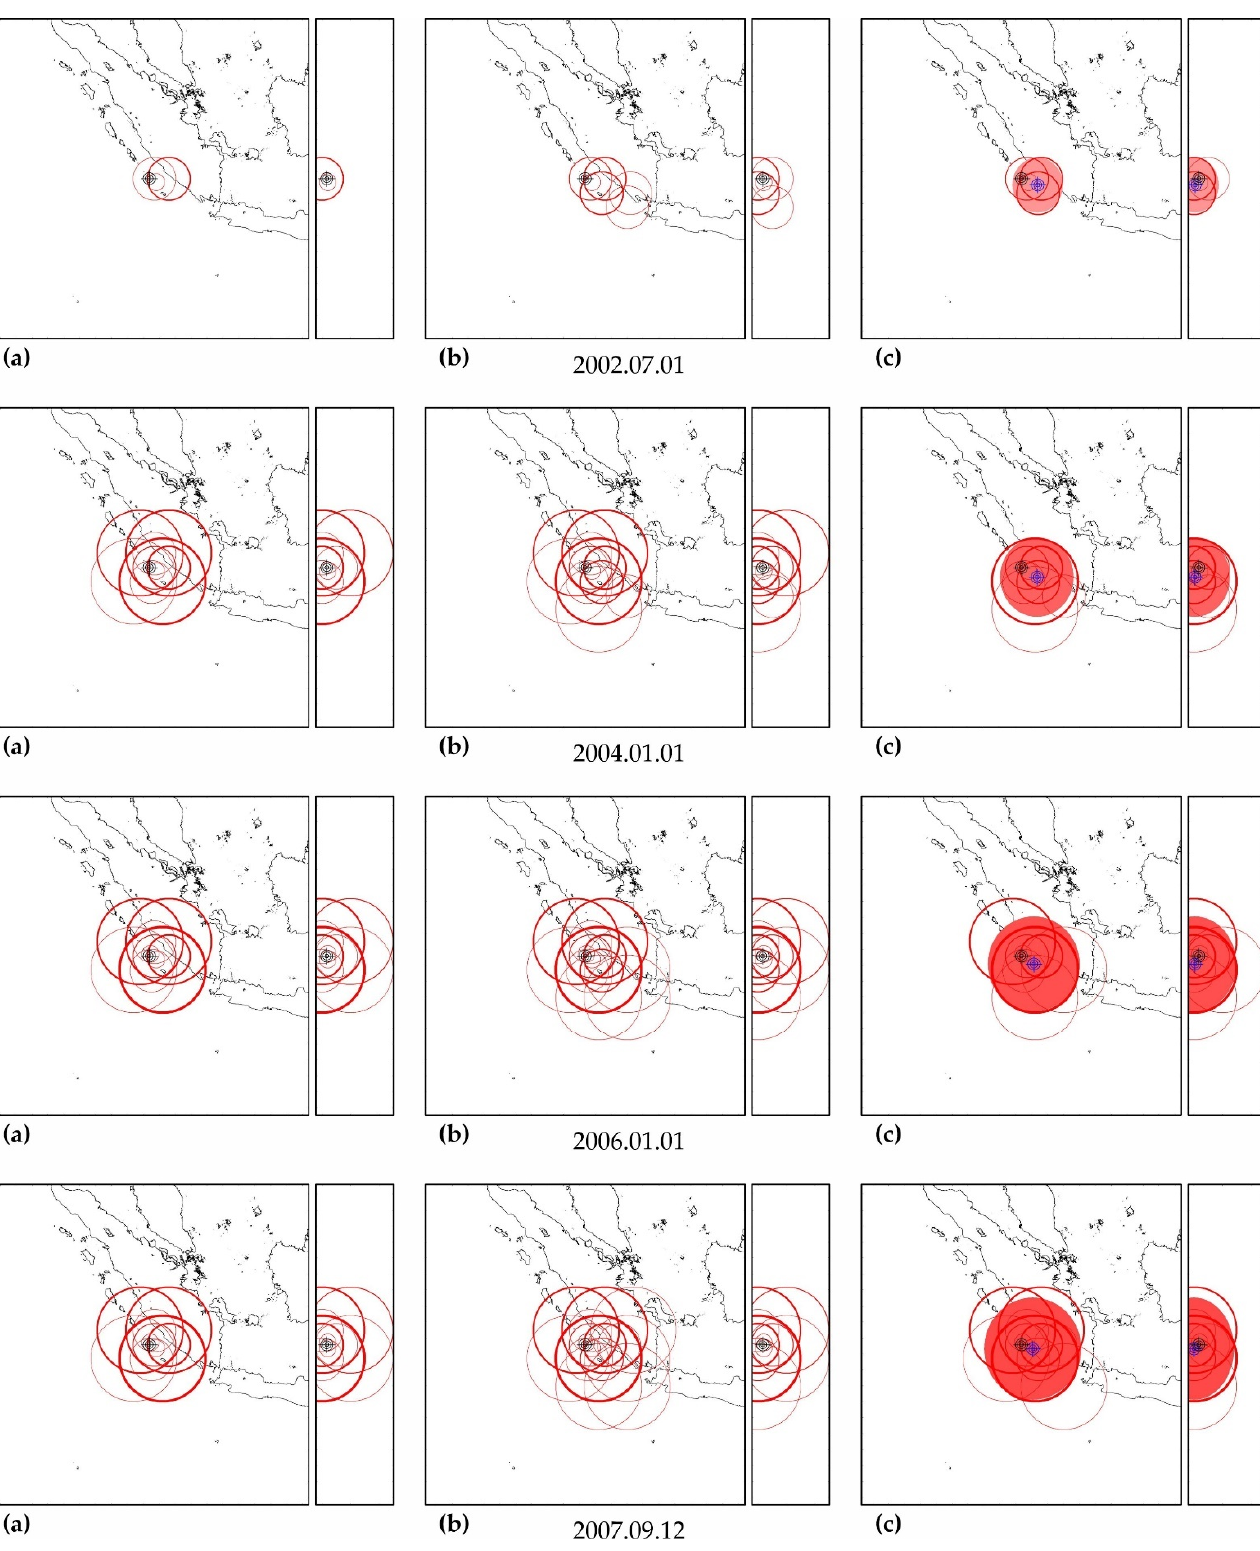
Figure A7. Zones of factual predictability for the earthquake of 12 September 2007 ( a ), identified zones with similar development according to the parameters of the DSDNP equation ( b ) and a cluster of zones of the greatest activity ( c ) used to calculate the time and place of a precedent earthquake (see Figure A3 for explanations).